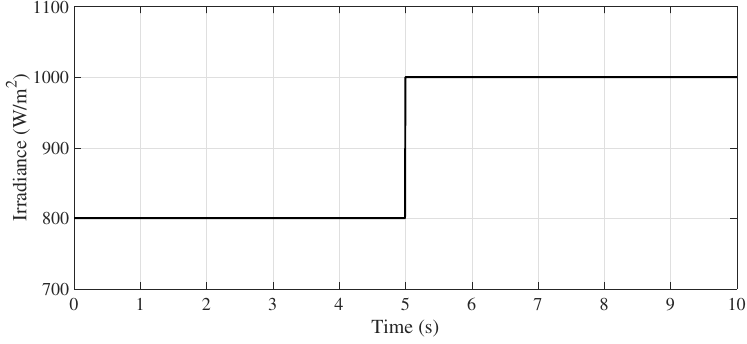
Figure 6. Irradiation profile for fixed